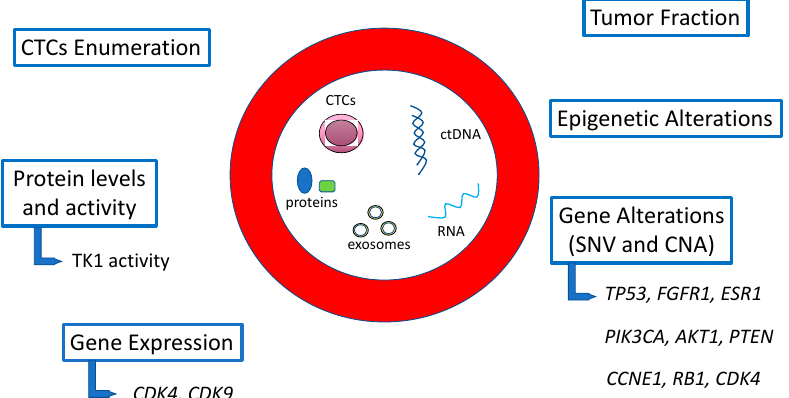
Figure 1. Schematic illustration of some of the potential circulating biomarkers of response to CDK4/6i in HR+/HER2 − BC discussed in this review (TK1 = thymidine kinase 1; SNV = single nucleotide variations; CNA = copy number alterations).